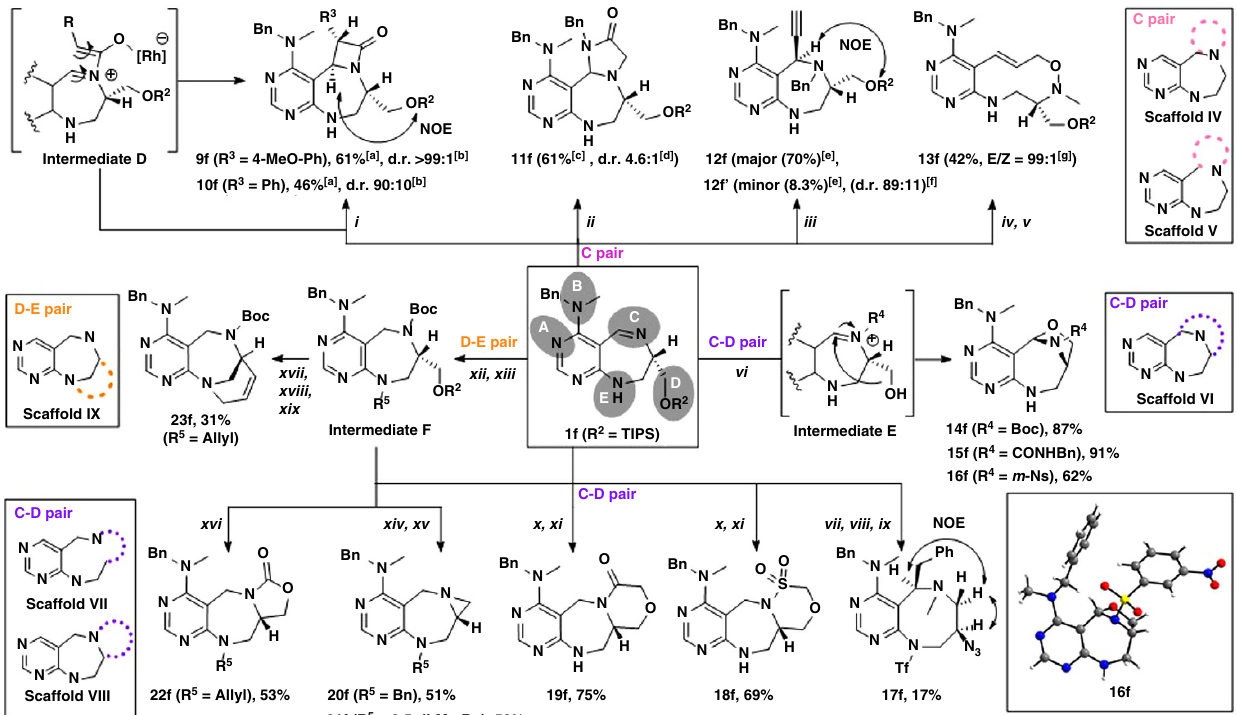
Figure 3 | C, C–D and D–E paring pathways for synthesis of scaffolds IV–VII. Reagents and conditions: ( i ) Rh(PPh 3 ) 3 Cl (10mol%), 4-picoline N -oxide, 4-ethynylanisole or phenylacetylene, ACN, m -wave, 90 (cid:2) C, 35min; ( ii ) N -benzyl-2-chloroacetamide, NaBr, DMF, m -wave, 110 (cid:2) C, 30min, then DBU,